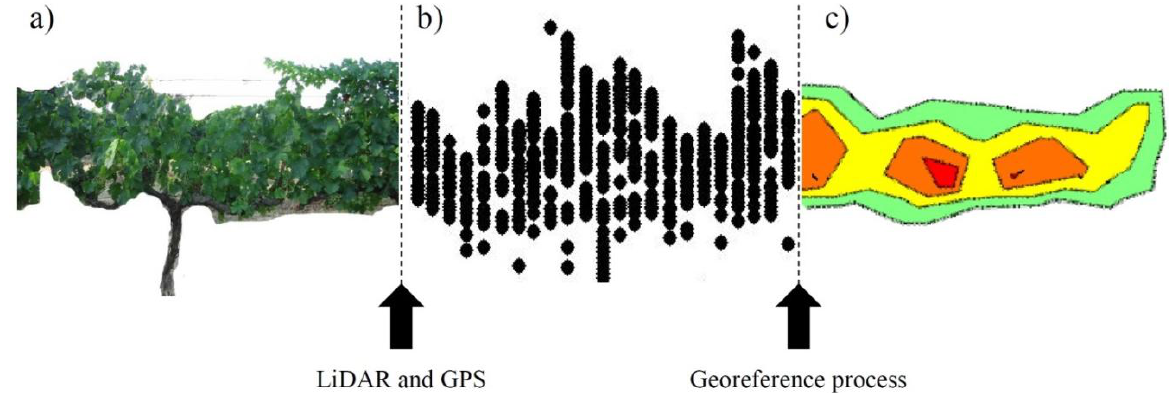
Figure 6. Graphical process to georeference LIDAR sensor data using the information provided by the DGPS system. The final results provide maps of the impact density in vineyards. ( a ) Image of real vines, lateral view; ( b ) Point cloud obtained, lateral view; ( c ) Impact density map generated, top view.